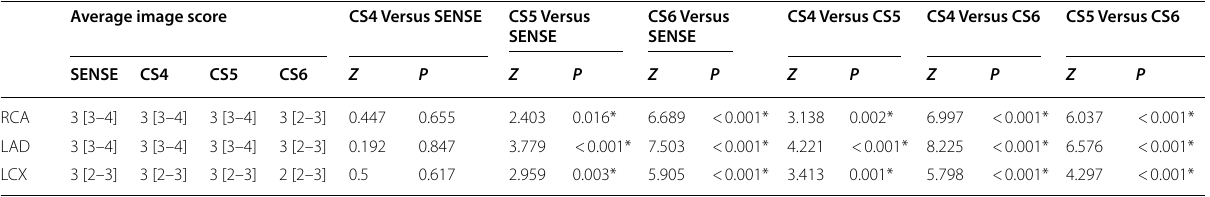
Metric data are reported as median and interquartile range. LAD including the left main artery RCA right coronary artery; LAD left anterior descending artery; LCX left circumflex artery *The difference was statistically significant ( p < 0.05)